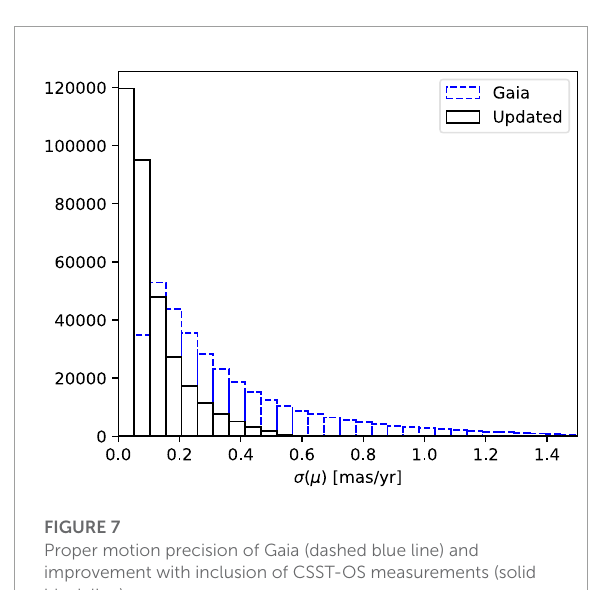
FIGURE 7 Proper motion precision of Gaia (dashed blue line) and improvement with inclusion of CSST-OS measurements (solid black